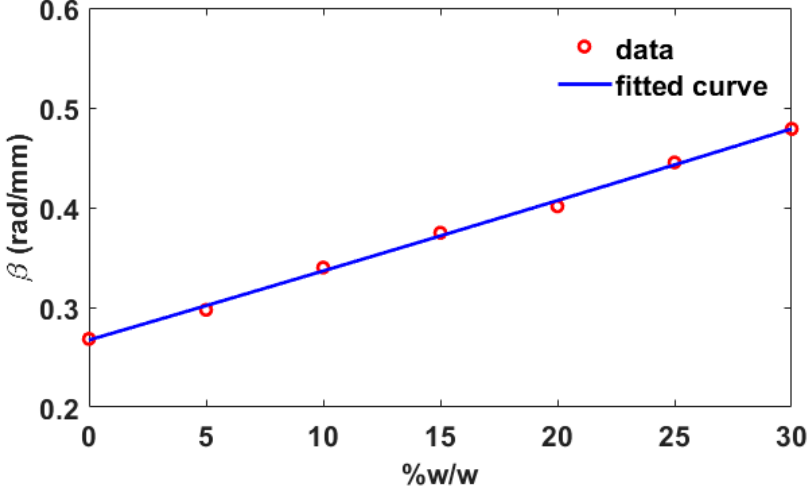
Figure 16. The curve fitting of the phase constant at the frequency of 4.0 GHz.